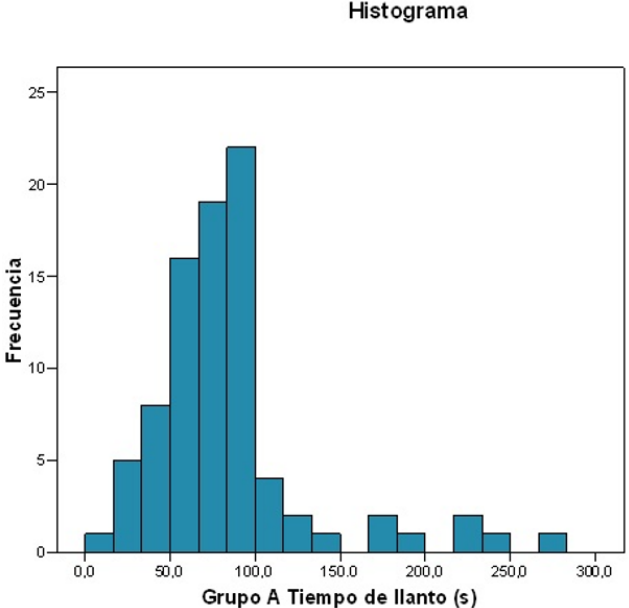
Figure 2. Histogram: Frequency of the duration crying time.